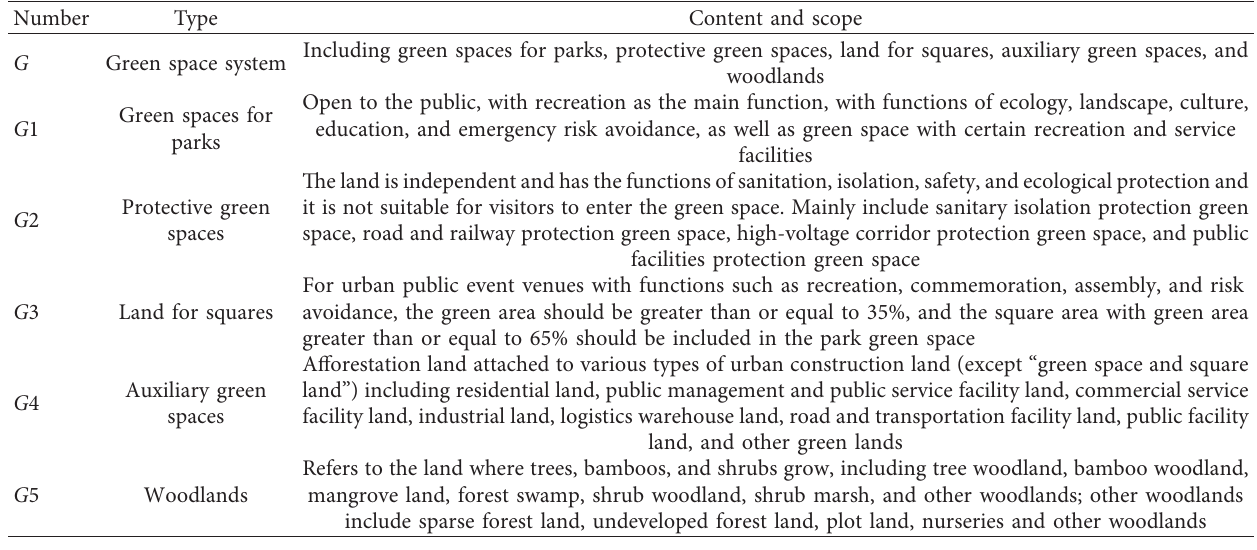
Table 1: Green land type classifications and